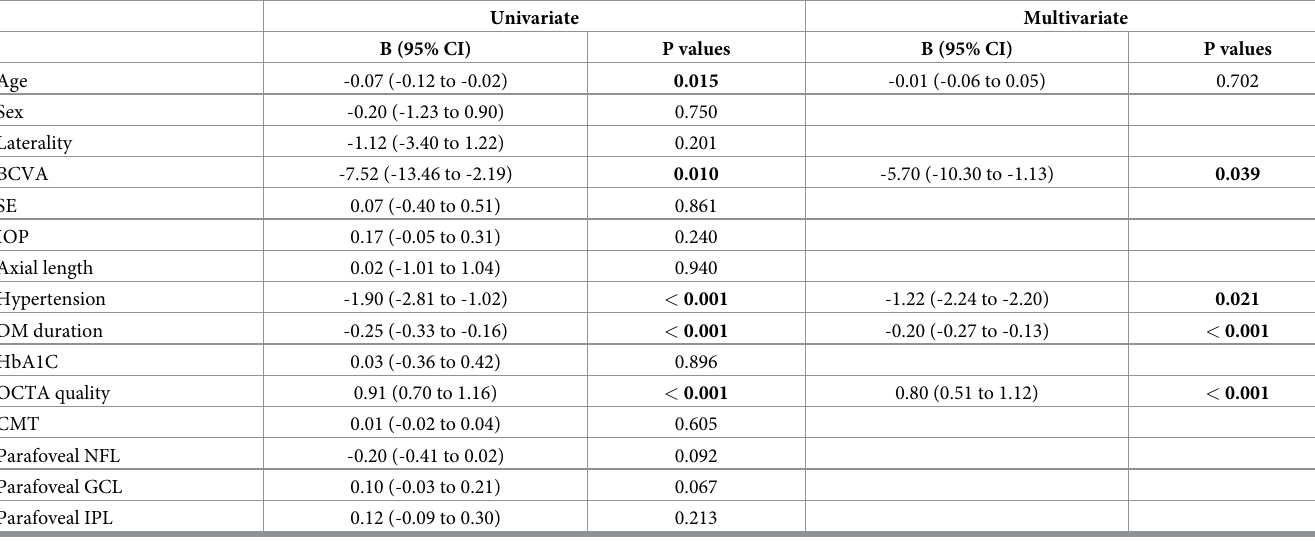
Table 4. Univariate and multivariate linear regression analyses determining factors associated with vessel density of deep capillary plexus in patients with type 2 diabetes. Univariate